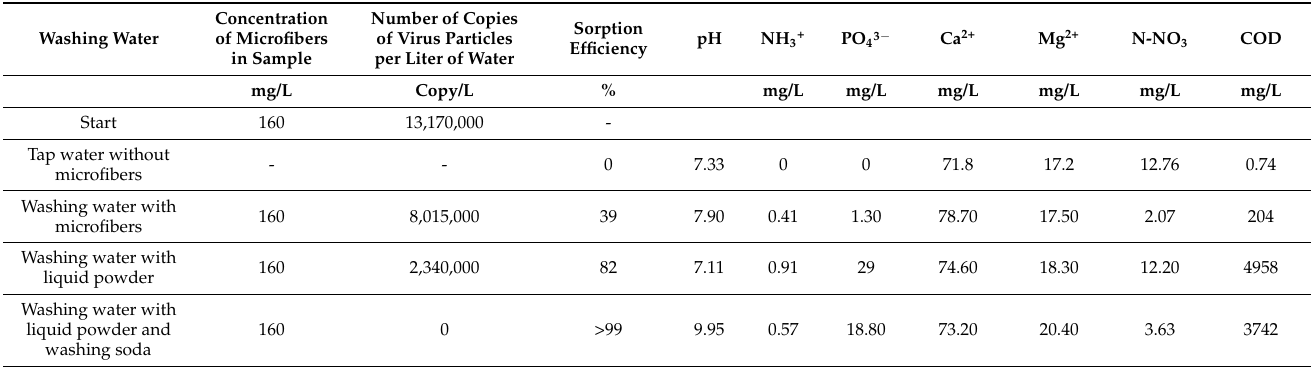
Table 1. The efficiency of washing water to remove SARS-CoV-2 virus particles and chemical parameters of washing